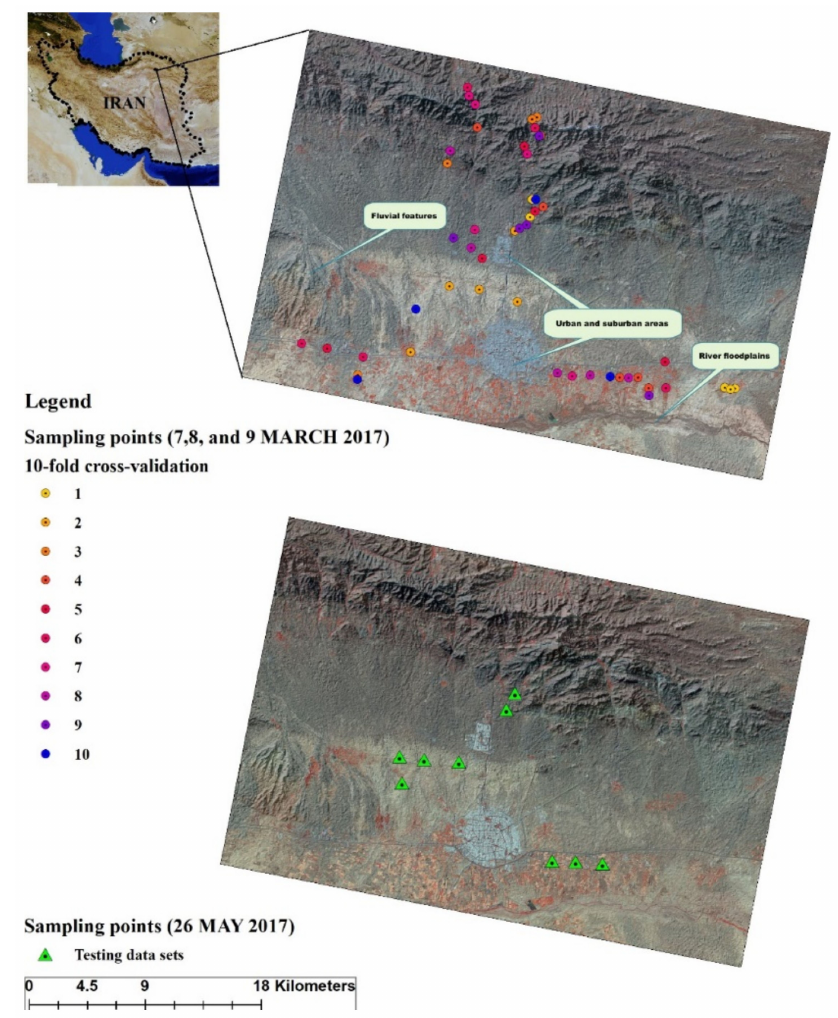
Figure 1. SMC data in the study area. Location of the 49 point samples (10-fold cross-validation framework) and 9 external testing point samples that cover di ff erent land-use types in the Sabzevar area. The external testing of the model was distributed throughout the study area in three di ff erent topographical conditions. Locations are shown on Landsat 8 OLI image dated 7 March